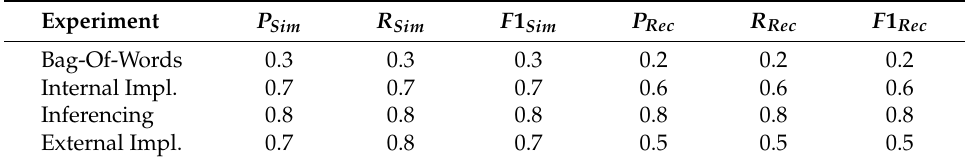
Table 5. Result of text analysis based on the Washington Post News